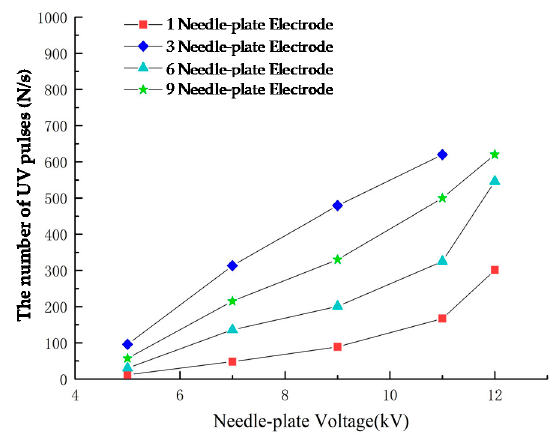
Figure 15. The relationship between the number of needle plates and the number of UV pulses (D = 3 cm, L = 15 cm).